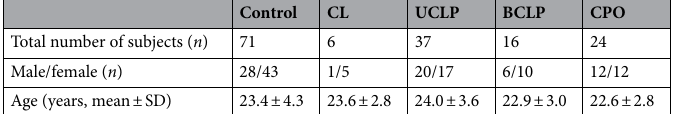
For those patients for which we have data indicating when they had surgery with both cheiloplasty and pala- toplasty (n = 37), 35 were operated on with cheiloplasty first, one was operated on with palatoplasty first, and one was operated with cheiloplasty and palatoplasty simultaneously. The median age of the patients when cheiloplasty was performed (n = 47) was 5 months, with an average age of 10.2 months. The median age value for palatoplasty (n = 51) was 17 months, with a mean value of 21.4 months. Different techniques were used for cheiloplasty, which mainly depended on the type of cleft and the preference of the surgeon. From the total of patients operated with any type of primary cheiloplasty (n = 57) in the partici- pant hospitals, the technique most commonly used was Millard (n = 20, 35.1%), and, to a lesser extent, Malek (n = 3, 5.3%), Tennison-Randall (n = 2, 3.5%), Veau Axhausen (n = 2, 3.5%), and Manchester Mendoza (n = 1, 1.75%), with no data on the surgical technique used (n = 29) in 49.1% of the patients. Several patients required two or more cheiloplasties (n = 34). From those, the Mulliken and Fisher techniques were used in five (14.7%) and one (2.9%) patient, respectively. We have no data on the technique used in this case (n = 28) for 82.3% of the patients. From the total of patients operated on with any type of palatoplasty (n = 57) in the participant hospitals, the techniques used were the Sanvenero-Rosselli (n = 15, 26.3%), Veau Wardill Kilner "push-back" (n = 11, 19.3%), Von Langenbeck (n = 7, 12.3%), or Furlow technique (n = 1, 1.75%) or gingivoperiosteoplasty (n = 1, 1.75%), and we have no data on the technique used (n = 22) for 38.6% of the patients. Of the patients from which we have data on nasal surgeries (n = 32), 18 (56.2%) were treated with primary rhinoplasty, whilst 14 (43.7%) needed secondary rhinoplasty or even more nasal surgeries. We have scarce infor- mation on the techniques used, but they were either open rhinoplasty, closed rhinoplasty or rhinoseptoplasty, using either osseous or cartilaginous grafts. Patients underwent between 1 and 11 surgeries from infancy to maturity, with a median value of 4 and an average of 4.39. Two surgeons per hospital operated on all the patients of each hospital. This sample was divided into four groups (Table 4): cleft lip (CL), unilateral cleft lip and palate (UCLP), bilateral cleft lip and palate (BCLP), and cleft palate only (CPO). The inclusion criteria for the study group were.